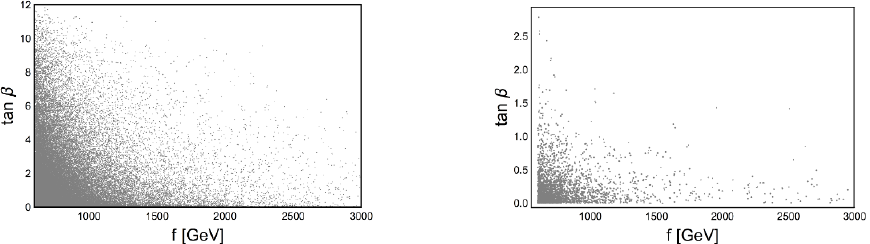
Figure 5 . Correlation between tan (cid:12) and f . Left: full potential. Right: potential without the gauge contribution.